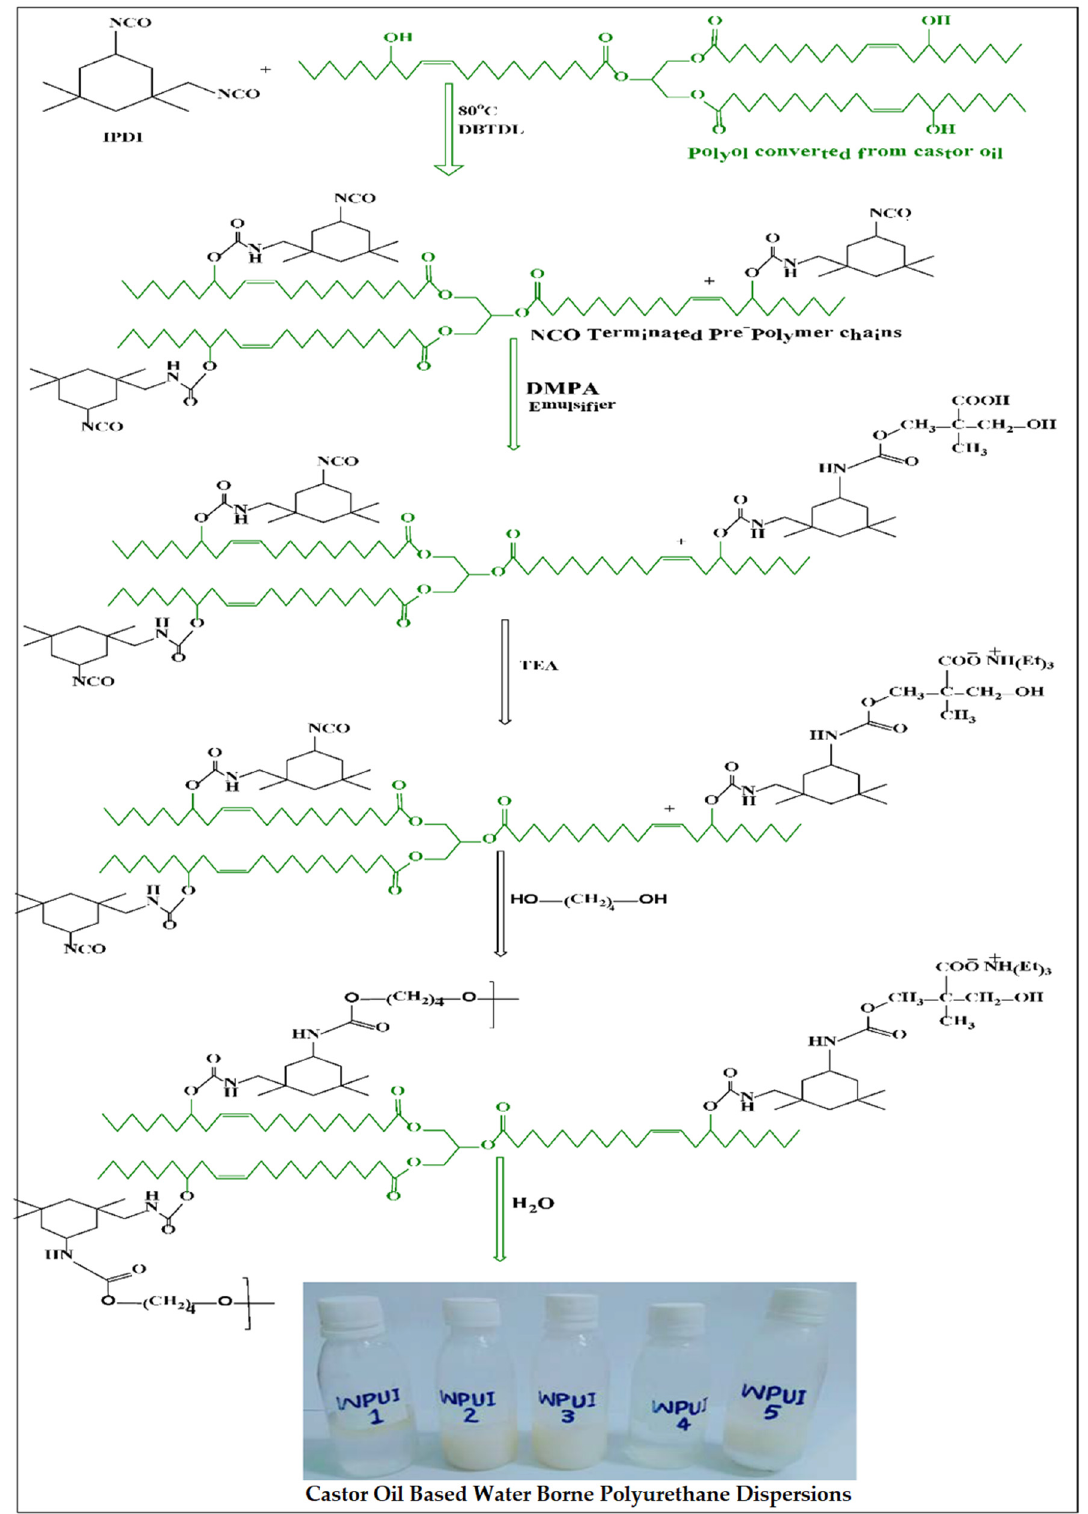
Figure 1. Synthetic route for the bio-derived polyol-based PU dispersions with IPDI for WPUI series representing five stages of dispersion formations, including a first stage of NCO-terminated prepolymer formation, second stage of emulsification with DMPA, third stage of neutralization with TEA, fourth stage of chain extension with BD, and fifth stage of dispersion of polymerized chains in deionized water.